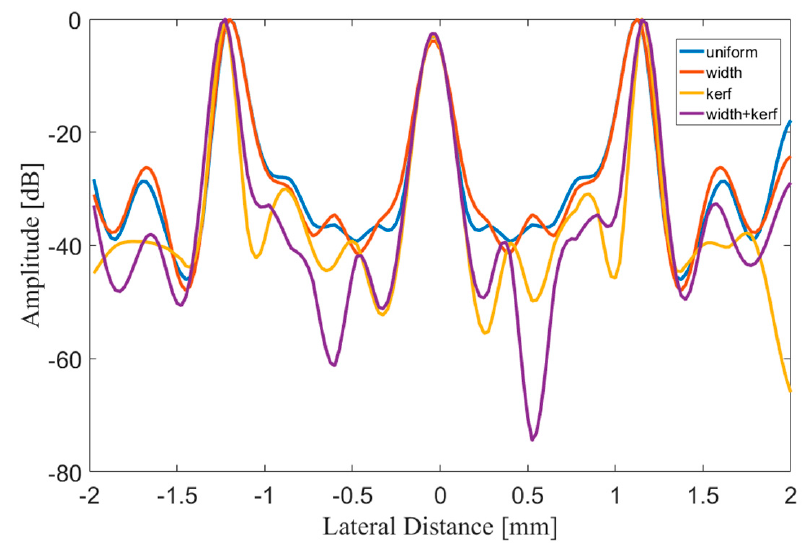
Figure 8. Lateral envelope of echo signals of the points inside the red rectangle from the uniform linear array (blue line), the MNULA with different widths (orange line), the MNULA with different kerfs (yellow line), and the MNULA with different kerfs and width (purple line).